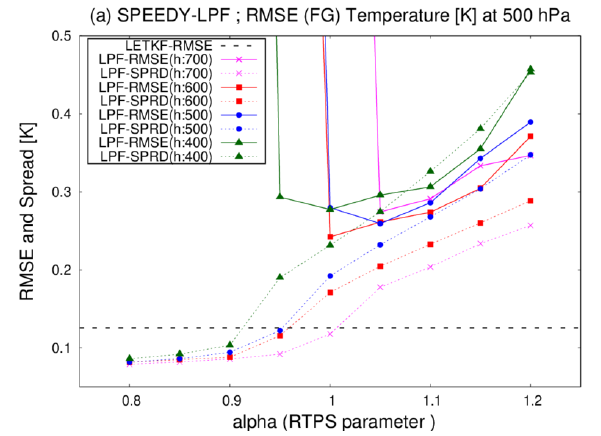
Figure 5. Time-mean background RMSEs (solid lines) and en- semble spreads (dashed lines) for T (K) at the fourth model level ( ∼ 500hPa) as a function of RTPS parameter α averaged over three months of the third year (February–April), with REG2 observations. Magenta, red, blue, and green lines are LPF experiments with hor- izontal localization scales of 700, 600, 500, and 400km, respec- tively. Dashed lines represent RMSE of LETKF (0.1257K), with adaptive multiplicative inflation instead of RTPS.